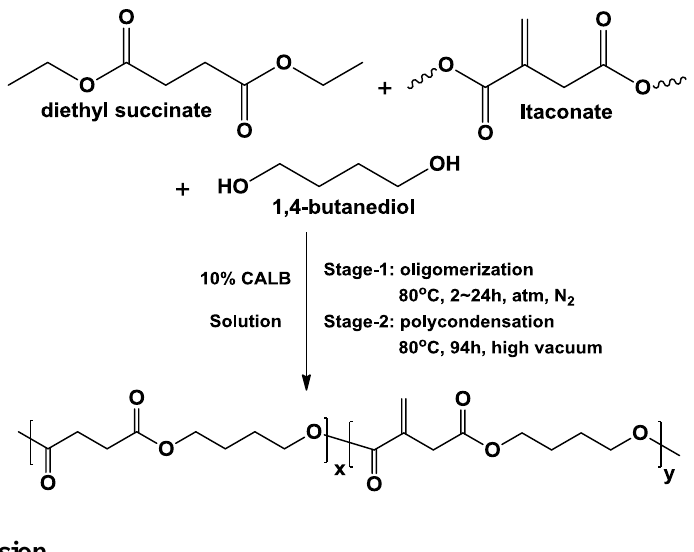
Figure 1. Candida antarctica Lipase B (CALB)-catalyzed co-polymerization of succinate, itaconate and